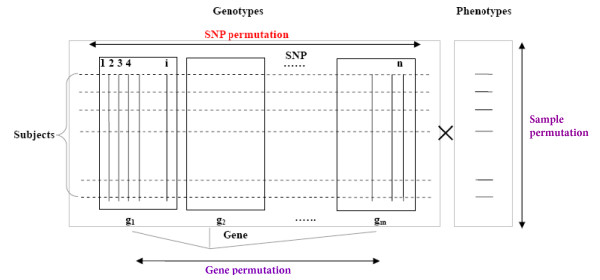
The scheme of different permutation processes. Horizontal dashed lines denote genome-wide genotype information of a study subject. Vertical lines denote SNP positions. Black boxes represent regions in which SNPs are annotated to a specific gene.